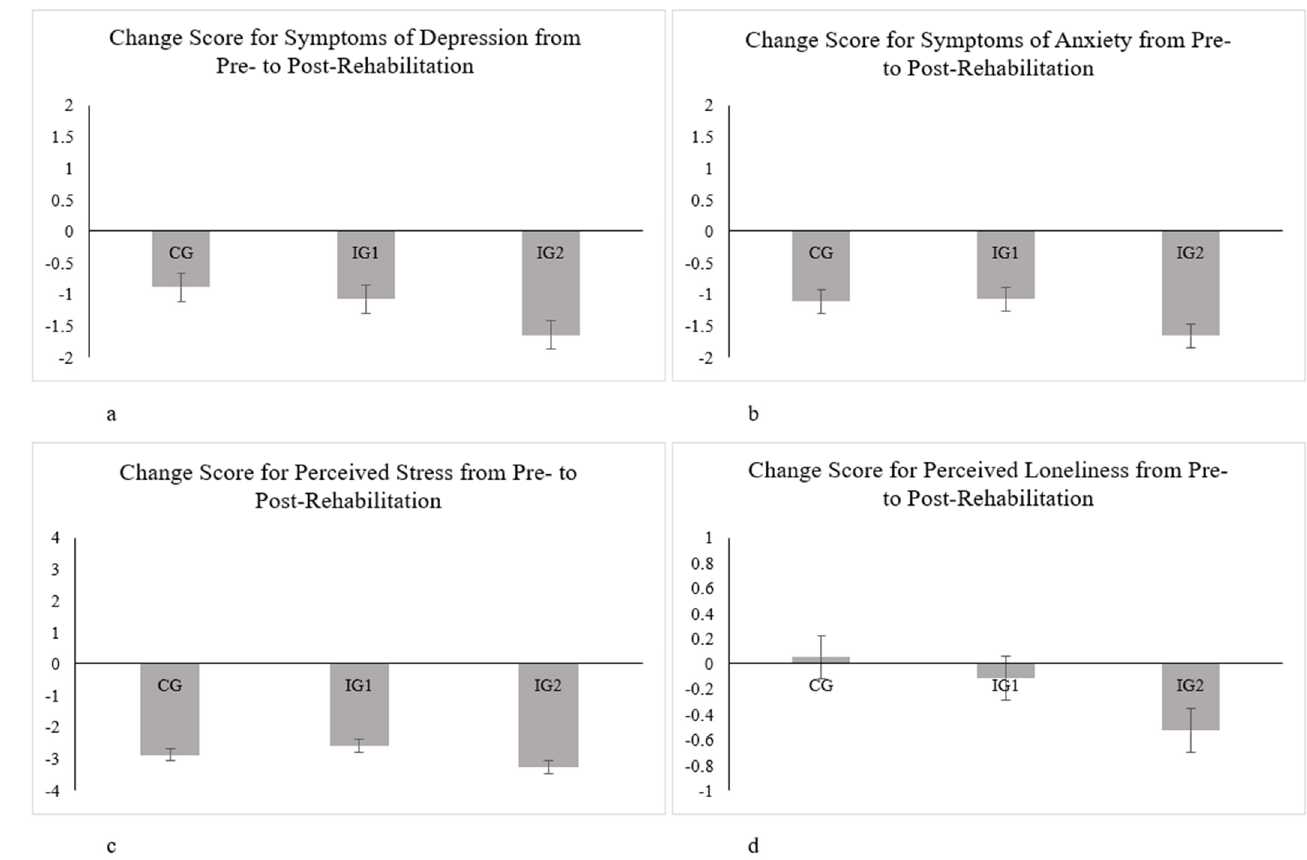
Figure 1. Estimated marginal means for symptoms of depression ( a ), symptoms of anxiety ( b ), perceived stress ( c ), and perceived loneliness ( d ). Error bars are represented by standard errors of the mean. Higher negative scores represent a greater reported symptom change from pre– to post–rehabilitation and, thus, a better mental health status post–rehabilitation.